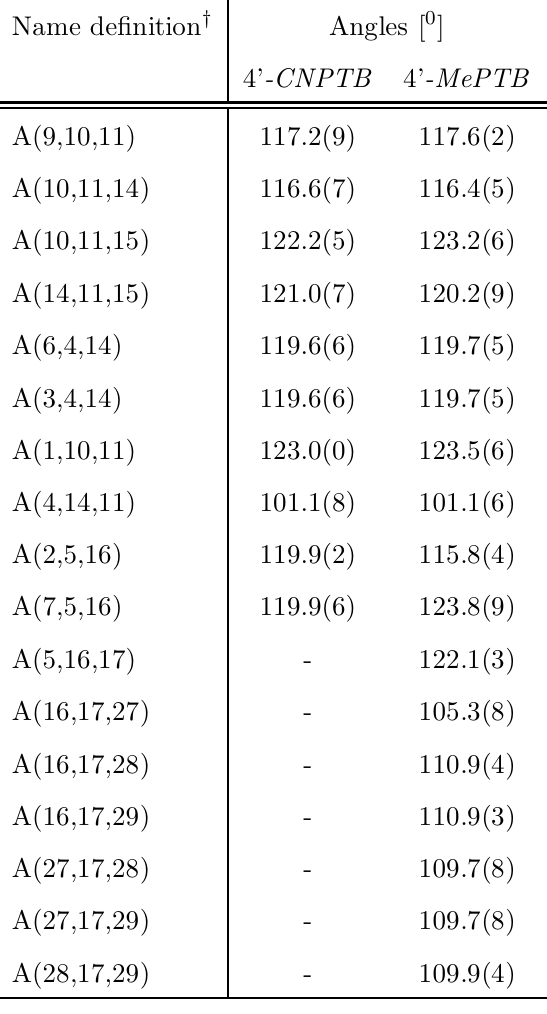
Table 1 (¯rst half) Selected structural parameters, optimized for 4’-CNPTB and 4’-MePTB. A(C ar C ar C ar ) range within 119.9096 { 120.6084 (4’-MePTB); 119.8815 - 120.3406